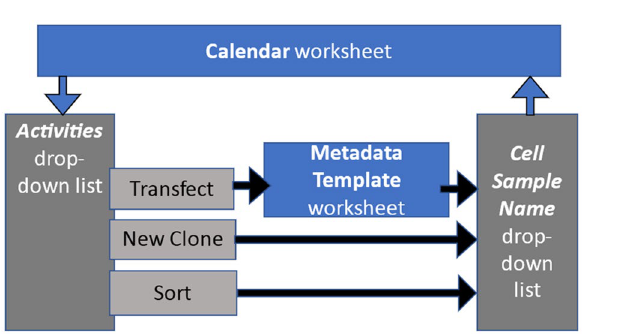
Figure 2. Components of the user interface program for collecting metadata. The user can enter data on two interrelated worksheets, the transfection Metadata Template worksheet and the Calendar worksheet (shown in dark blue). Cell sample names are automatically updated according to the naming convention in response to certain selected activities, and this list updates the Cell Sample Name drop-down list on the Calendar for selection by the